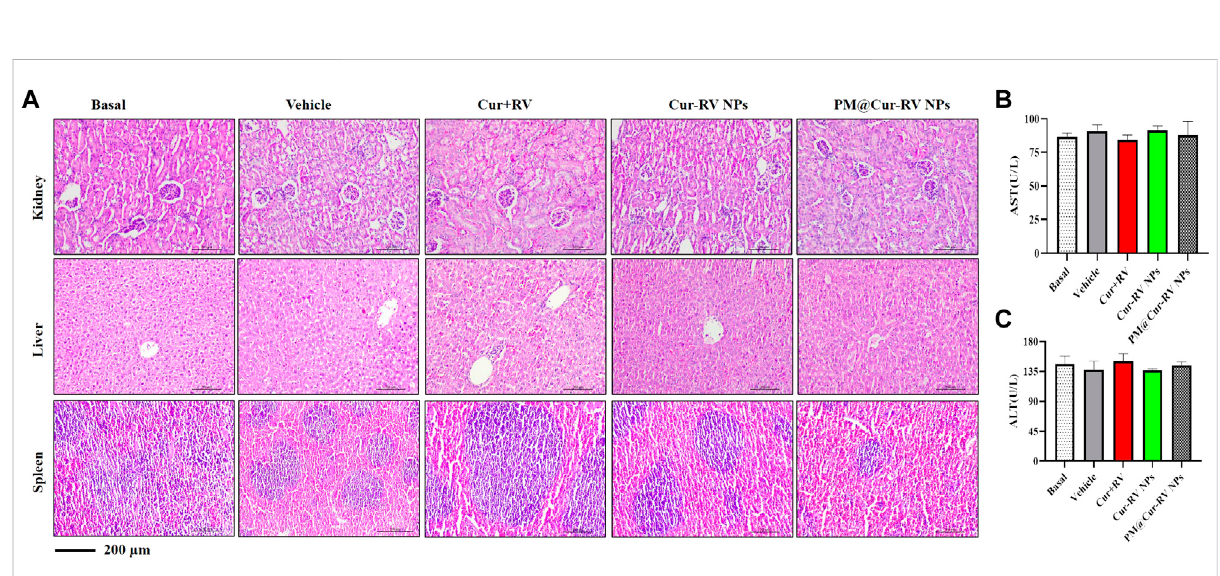
FIGURE 6 ToxicologicalstudiesinALImice. (A) PathologicaldatausingH&Estainingofdifferentorgans(Kidney,LiverandSpleen)originatedfromALImice inhaledwithdifferentcompounds.Noobvioustoxicitywasobserved.Magni fi cation(×400). (B – C) Thelevelsofaspartateaminotransferase(AST)and alaninetransam(ALT)ofliversweretestedtoevaluatethetoxicityofdifferentformulationsofCur-RV.Therewasnostatisticalsigni fi canceamongthe